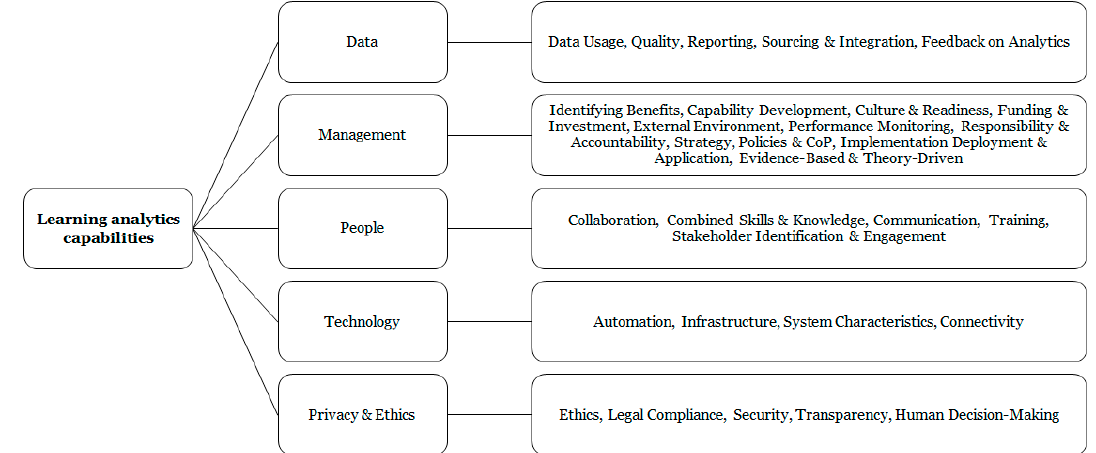
Figure 1. Capability model for learning analytics.